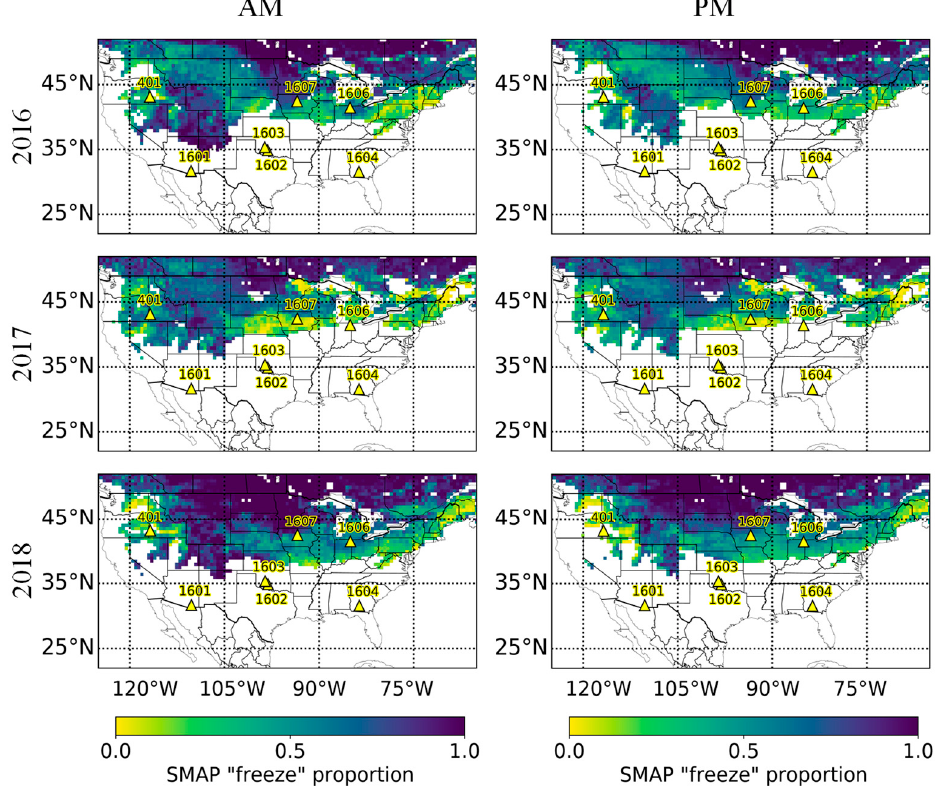
Figure 11. SMAP ‘freeze’ fraction for CONUS. This metric is computed for each grid cell by dividing the number of SMAP ‘freeze’ classifications by the total observations during January and February each year. Masked regions are shown in white.